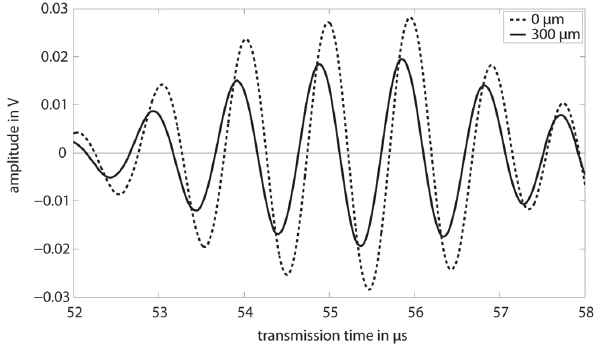
Figure 16. The acoustic receiver signal of receiver 1 through the liquid-filled tube without and with a 300 µ m coating of adhesive tape on the emitter